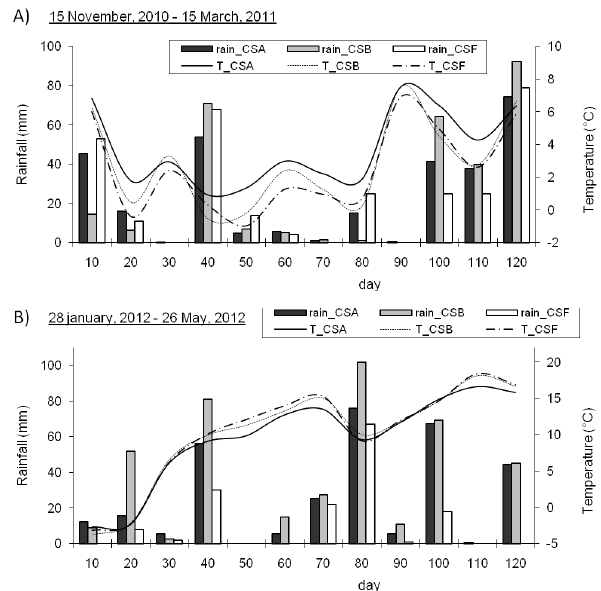
Figure 1. Temperature (lines) and rainfall (bars) measured in the three vineyard sites (CSA, CSB, CSF) for 120 days before the soil samplings in 2010–2011 (a) and 2012 (b)